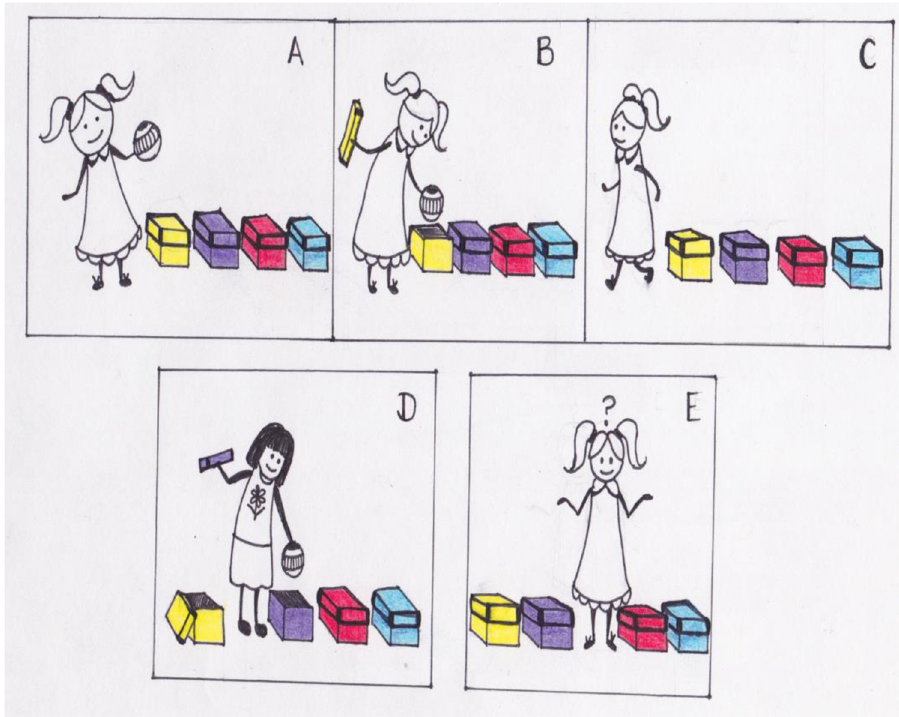
Fig 2. A depiction of the four-box Sally-Ann task used in the present experiment. The researcher presented each child with a visual enactment of four false belief scenarios using colorful stick figures. Each scenario involved a protagonist (a) who put an object in one of the four containers (b). Then, the protagonist leaves (c), and another character placed the object in a different container (d). In one scenario for example, the researcher said to the child: “ Sally was playing with her ball , then she got hungry , so Sally put her ball right in here [purple container], and went home . When Sally was gone , Ryan hid Sally’s ball in a different spot ! He may have hid it here , or here , or here” [researcher pointed to each of the other containers]. In two scenarios (i.e., Outcome Known Trials), the researcher told the child exactly where the second character placed the object (e.g., “ But we know that Ryan hid the ball here .” [blue container]). In the other two scenarios in contrast (i.e., the Outcome Unknown Trials), the researcher told the child: “But we don’t know where he hid it . ” Both trial types ended the same way (Panel E, e . g ., “Then , Sally came back . Where will she look for her